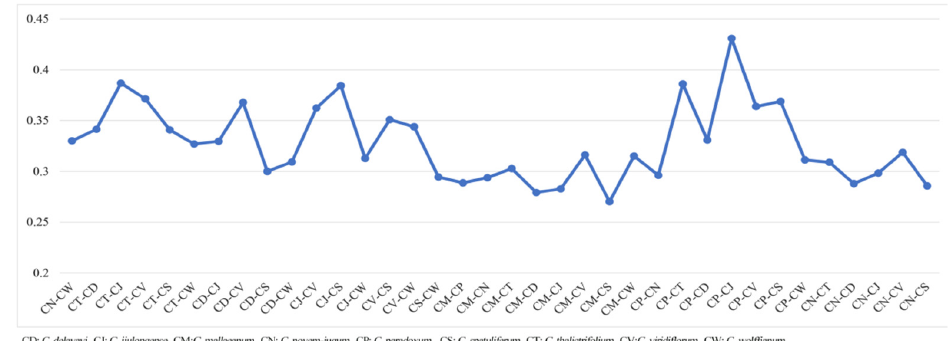
Figure 5. Codon content of 20 amino acid and stop codon in 53 coding genes of the Chamaesium plastid genome. The color of the histogram corresponds to the color of codons.